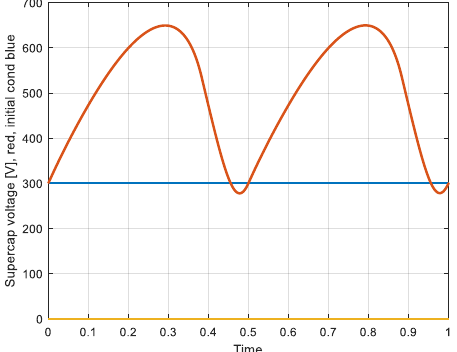
Figure 23. Current exchanged with the compensator capacitor(A).